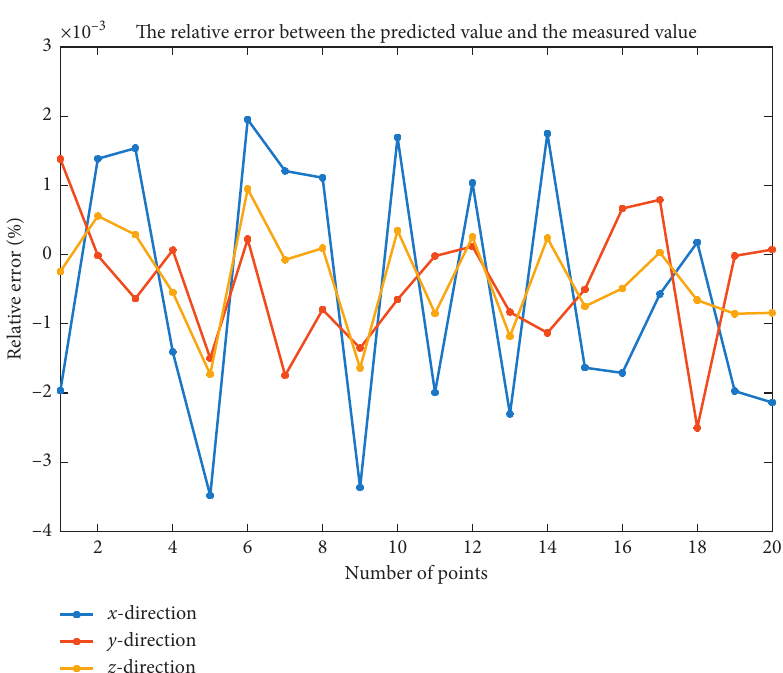
Figure 7: The accuracy for predicted value 0 Δ P